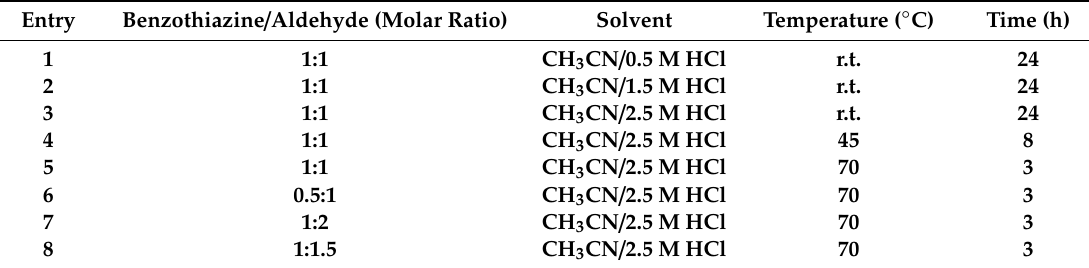
Table 1. Optimization of reaction condition for the synthesis of cyanine 1 .